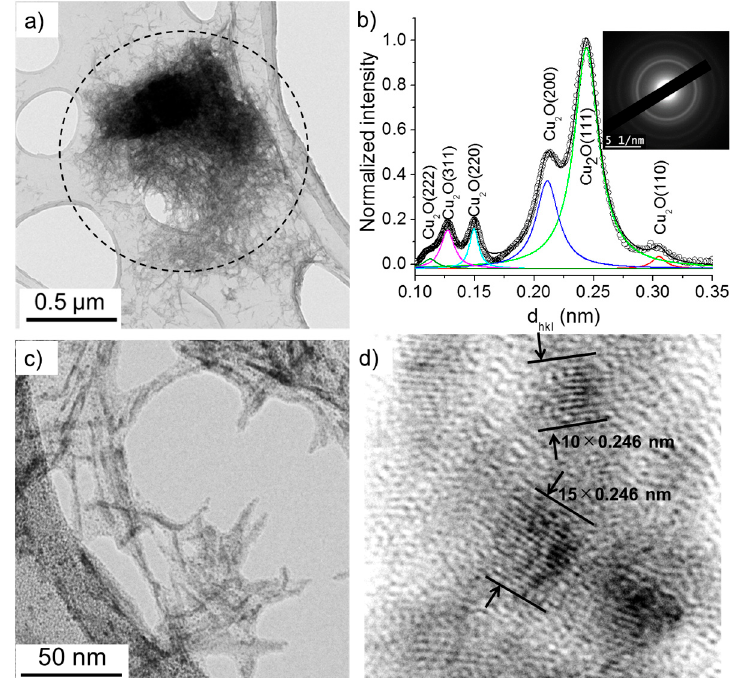
Figure 8. ( a ) TEM images of nanowires synthesized in deionized water ( σ 0 = 2 µS/cm) and ( b ) the corresponding selected area electron diffraction (SAED) pattern (performed on the encircled zone in ( a )) radially integrated spectrum. ( c ) and ( d ) show the HR-TEM images of nanowires.